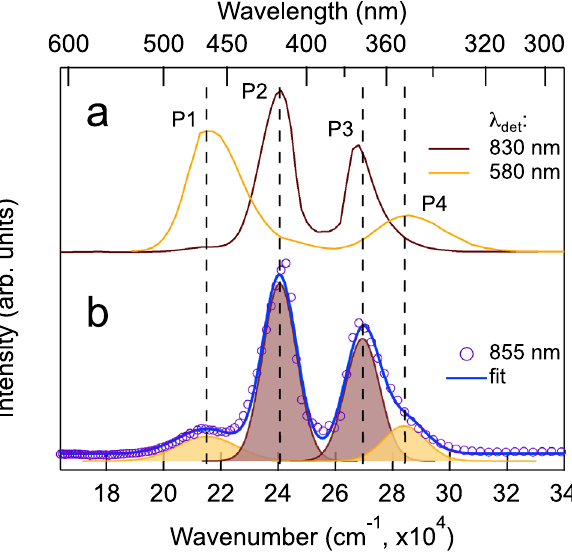
Figure 2. Excitation spectra. ( a ) PL excitation spectra of the ORPL and NIR2 bands. ( b ) PL excitation spectrum of the NIR1 band recorded at 855 nm and its multi-peak deconvolution. All the spectra were recorded at 1.47 K and zero magnetic